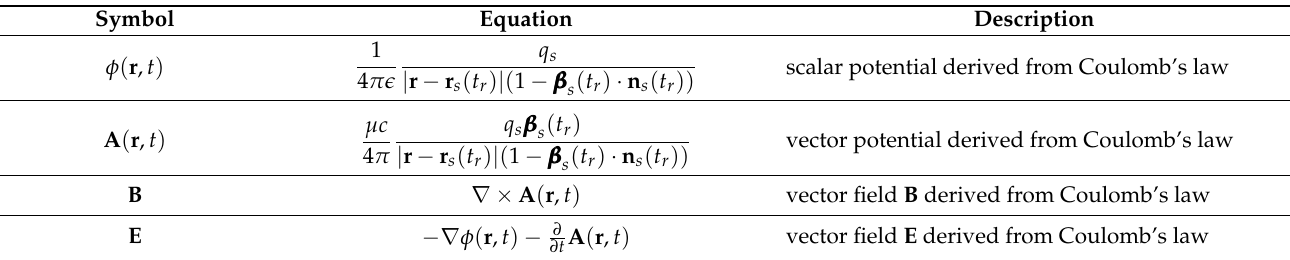
Table 1. Potentials and vector fields derived from Coulomb’s law.